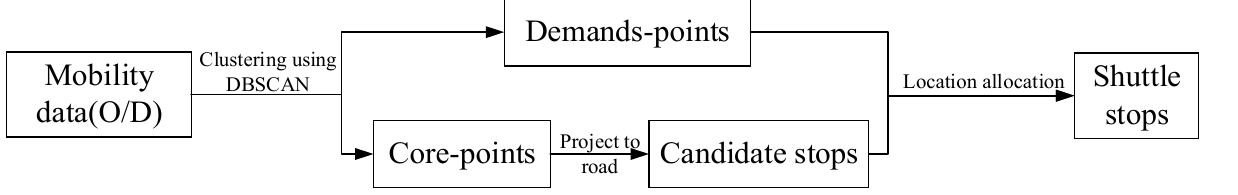
Figure 3. Flowchart of generating shuttle bus stops.